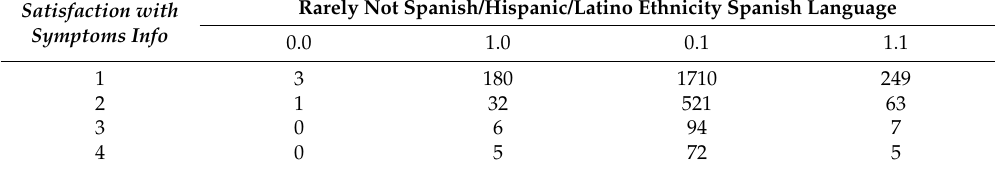
Table 11. Contingency Table for Satisfaction with Symptoms Info and rarely not Spanish/Hispanic/ Latino and Spanish Language.